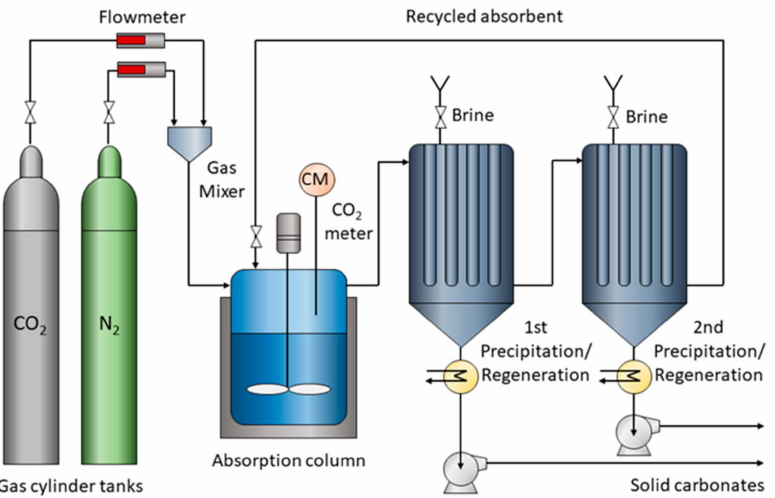
Figure 1. Experimental equipment and devices used for the multicycle integrated absorption–mineralization